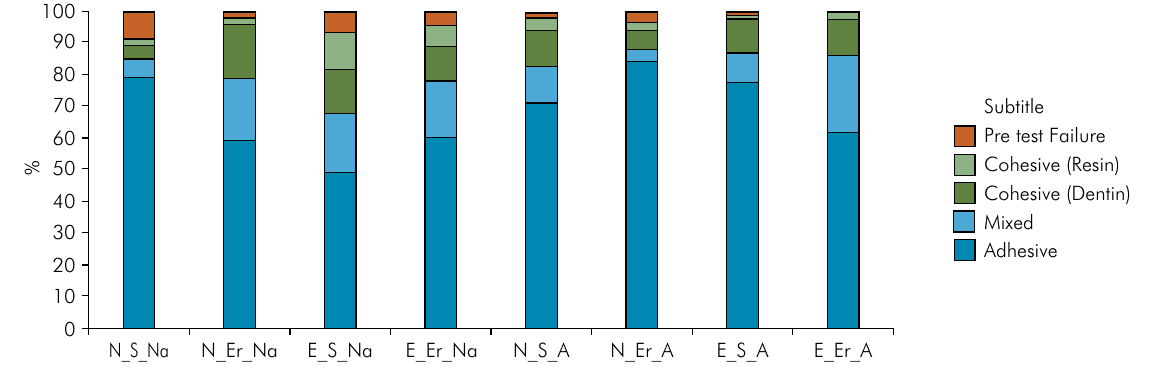
Figure 1. Percentage of fracture types wthin each group.